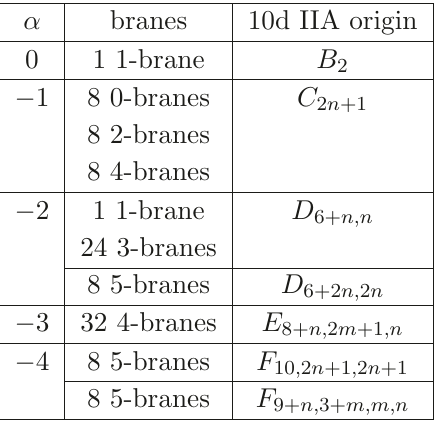
Table 9 . The branes of the IIA theory compactified on T 4 / Z 2 and their corresponding ten- dimensional origin in terms of mixed-symmetry